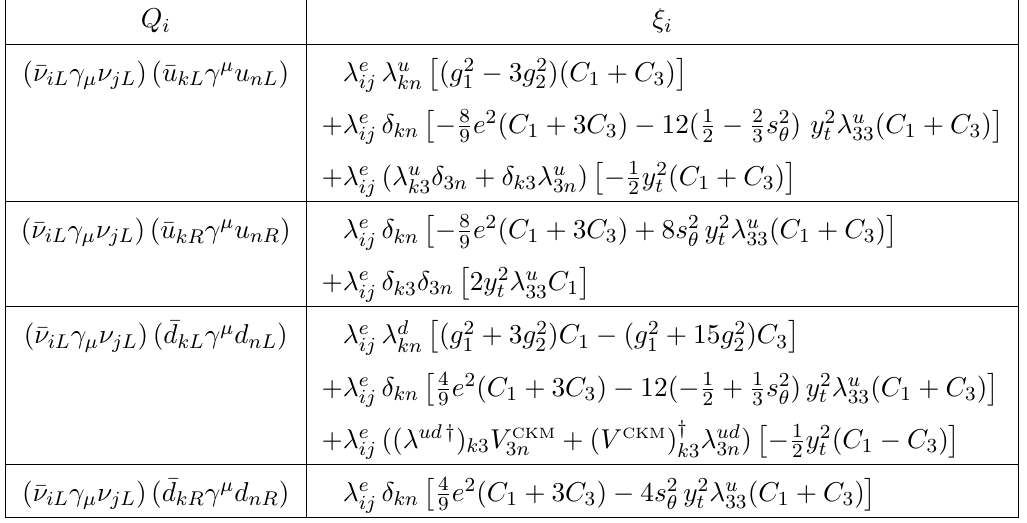
e(cid:11) . (cid:18)